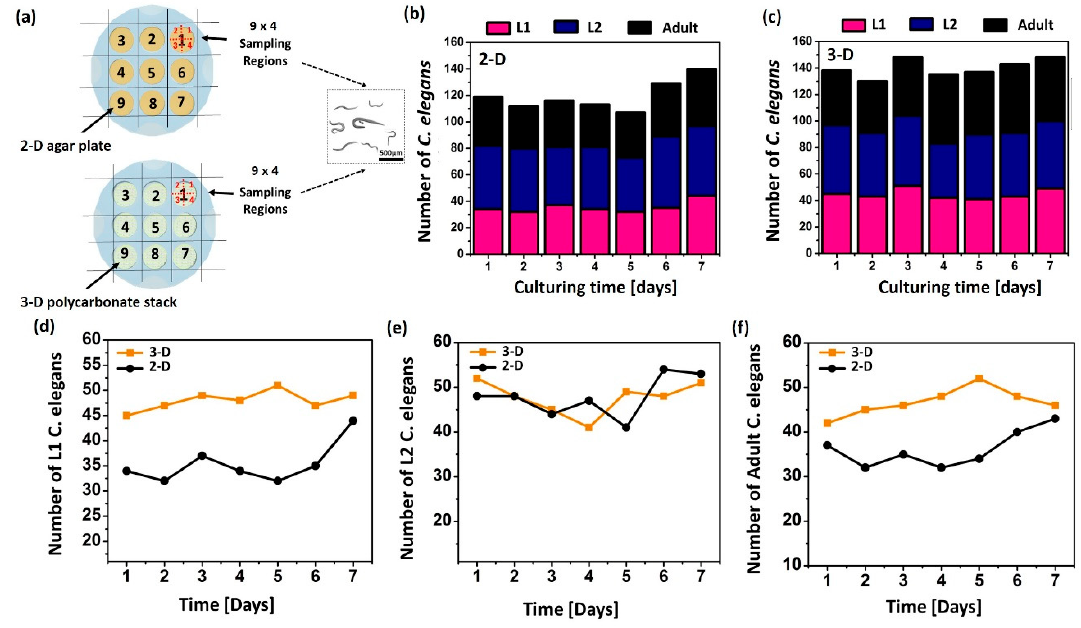
Figure 6. ( a ) Schematic illustration of experimental setup with two culture platforms. The number of C. elegans in L1, L2, and adult development stage ( b ) on the 2-D agar plate and ( c ) in the 3-D stack. Summary of the data with ( d ) L1, ( e ) L2, and ( f ) adult worms.